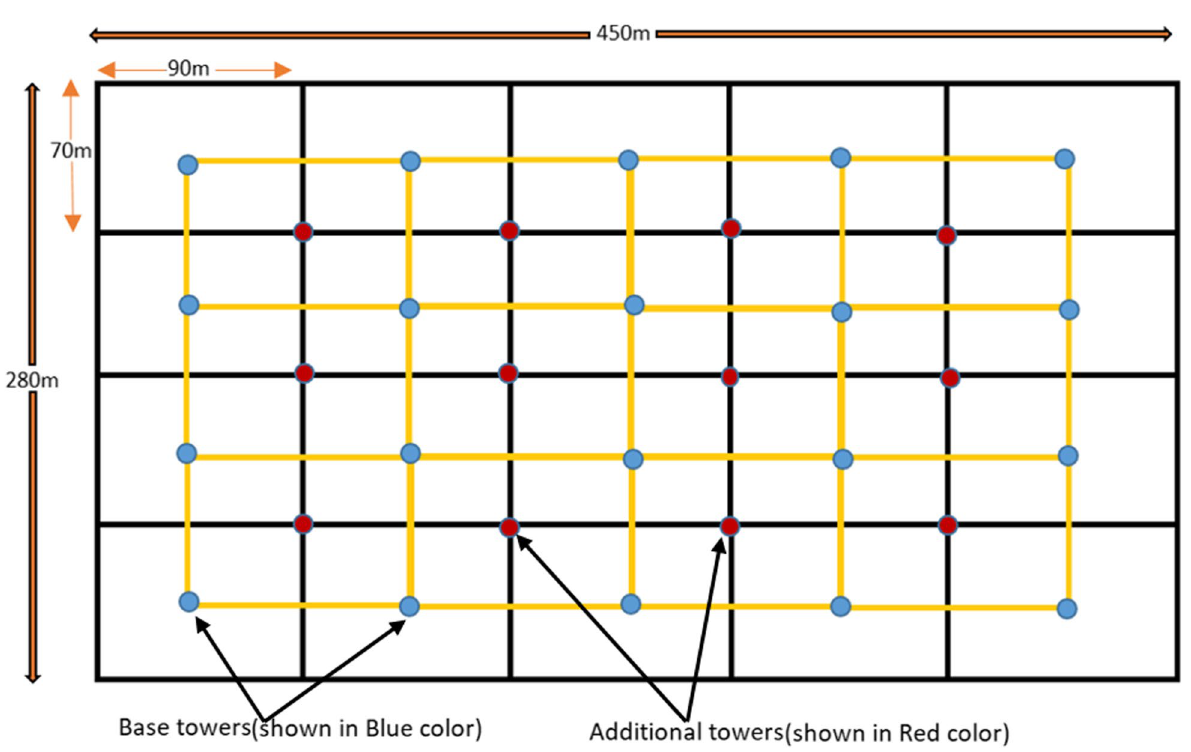
Fig. 5 Pole coverage of Lakvijaya coal yard. The blue dots are the towers to cover each of the 20 rectangles. The red dots show the location of supplementary towers which cover the bases of the first set of